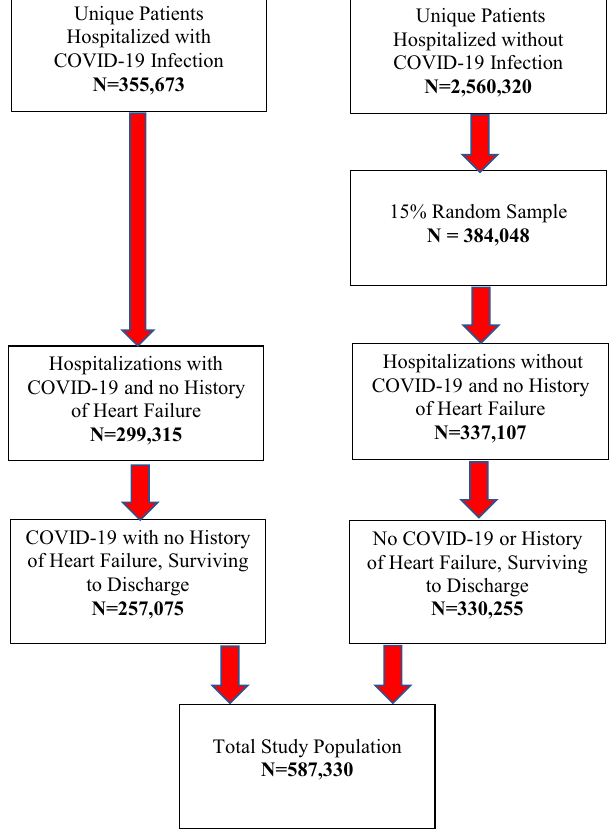
Fig. 1 Study population fl owchart. The total study population included 587,330 unique patients as in the following selection fl